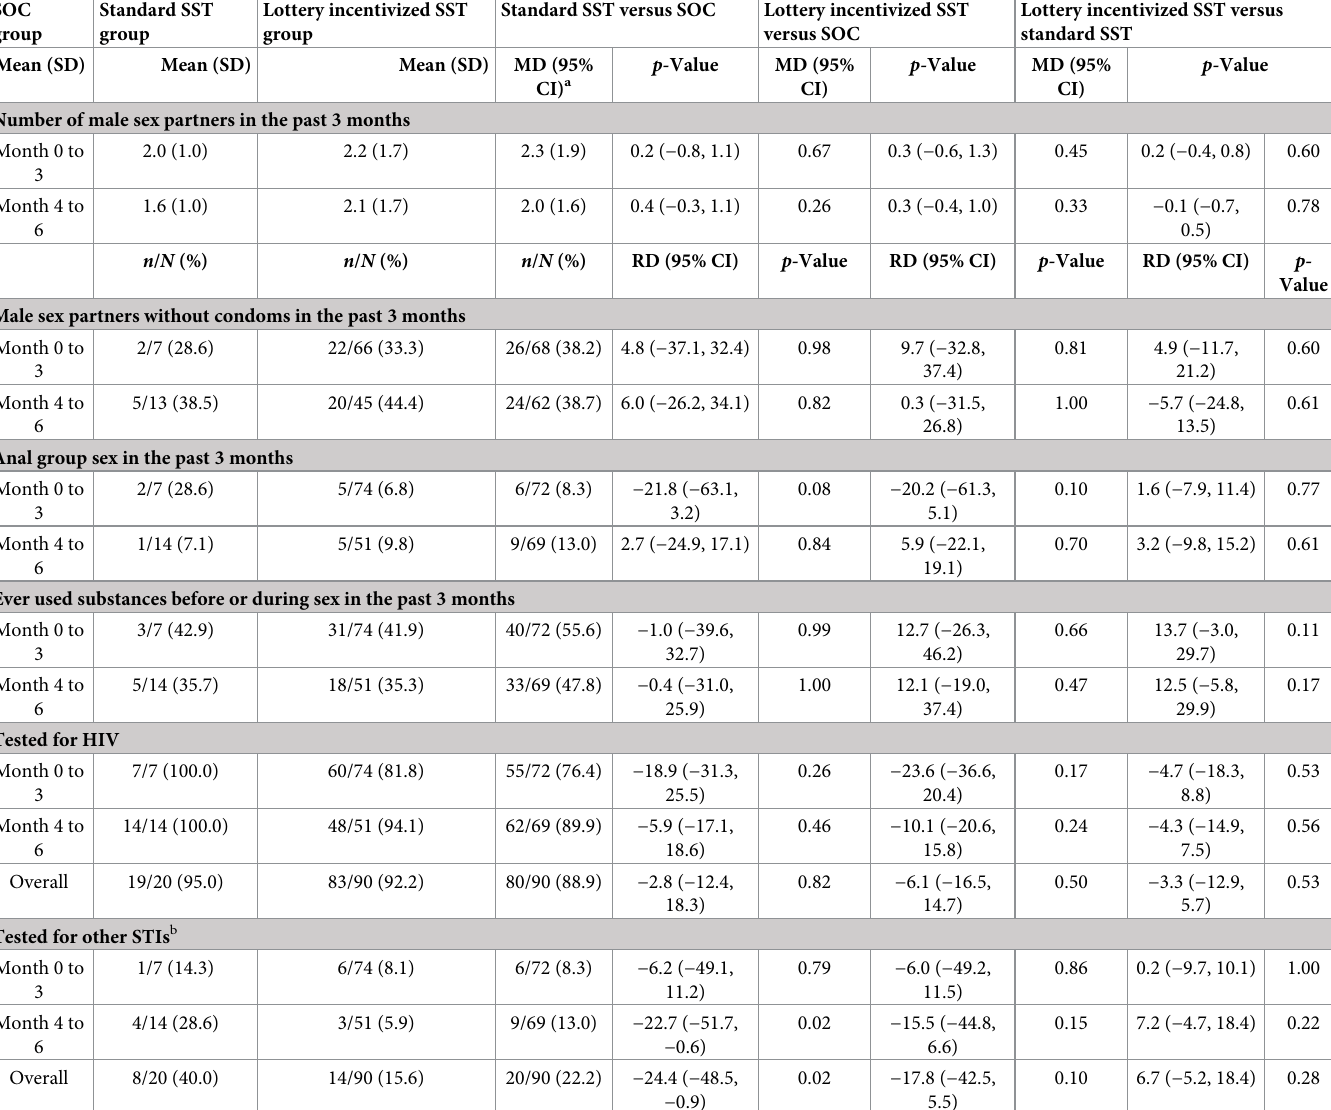
Table 4. HIV/STI testing and sexual behaviors self-reported by men who had syphilis testing during the trial and initiated at least 1 follow-up survey. SOC Standard SST group